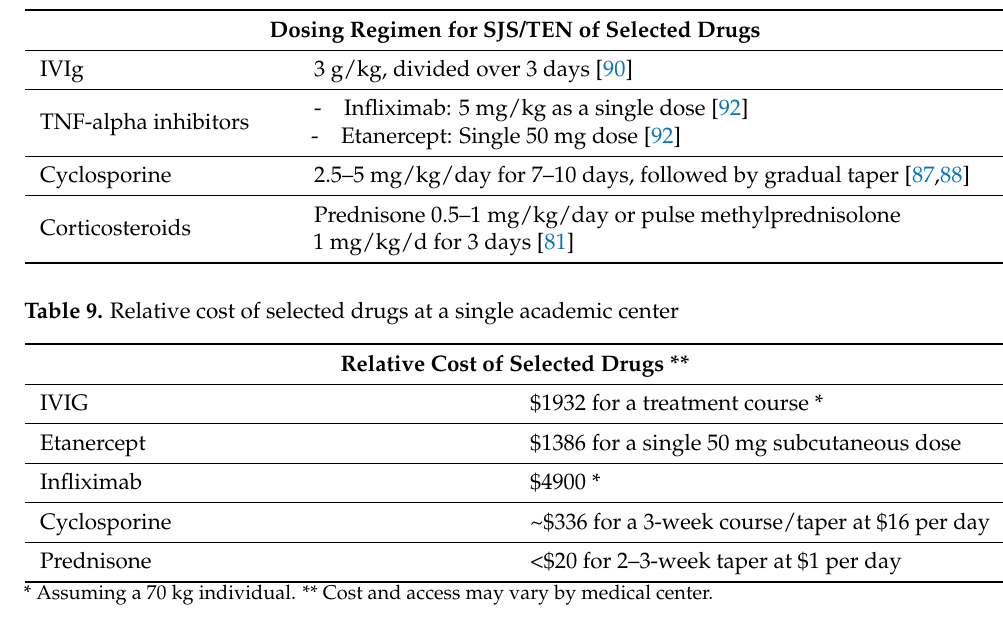
Table 8. Typical dosing regimens to treat SJS/TEN for selected drugs Dosing Regimen for SJS/TEN of Selected Drugs IVIg 3 g/kg, divided over 3 days [90] - Infliximab: 5 mg/kg as a single dose [92] TNF-alpha inhibitors